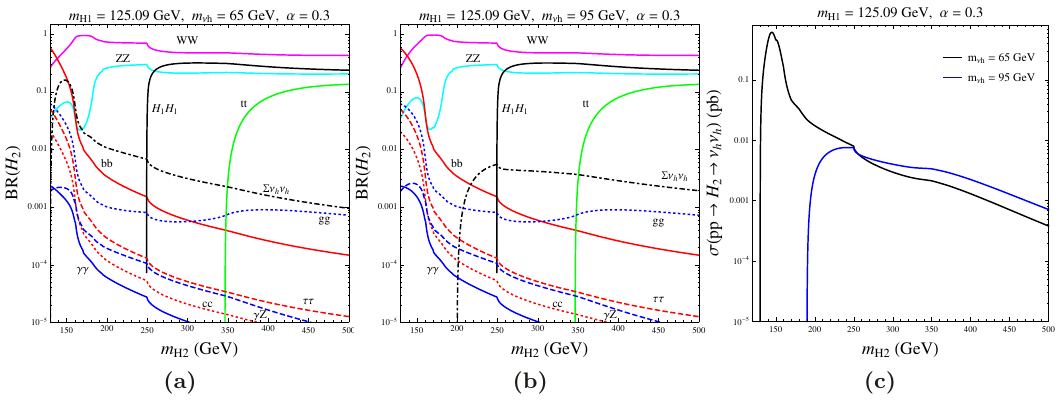
Figure 9. Branching ratios of the heavy Higgs H 2 for (a) m ν h = 65 GeV and (b) m ν h = 95 GeV. (c) Heavy neutrino pair production rate as a function of the heavy Higgs mass for two values of the heavy neutrino mass: m ν = 65 GeV (black line) and m ν = 95 GeV (blue line). h h